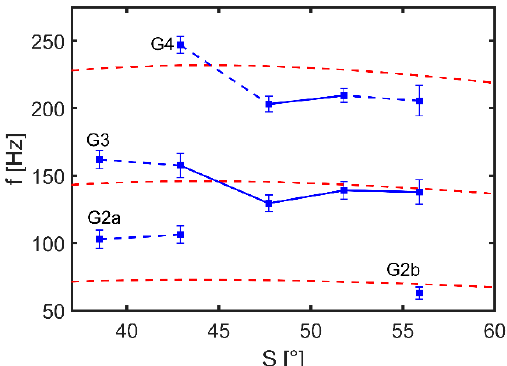
Figure 7. Experimentally determined resonance frequencies for GB-MBRs for di ff erent wall slopes S (blue) in comparison to resonance frequencies calculated with Equation 3 (red dashed lines). The resonance frequencies were determined as the positions of local maxima of | u | lat determined by fitting a Gaussian normal distribution. The obtained standard deviations are given as error bars. Data points were grouped and named (G2 to G4) based on the associated resonance mode. Data points connected only with dashed lines indicate same resonance modes but di ff erent flow